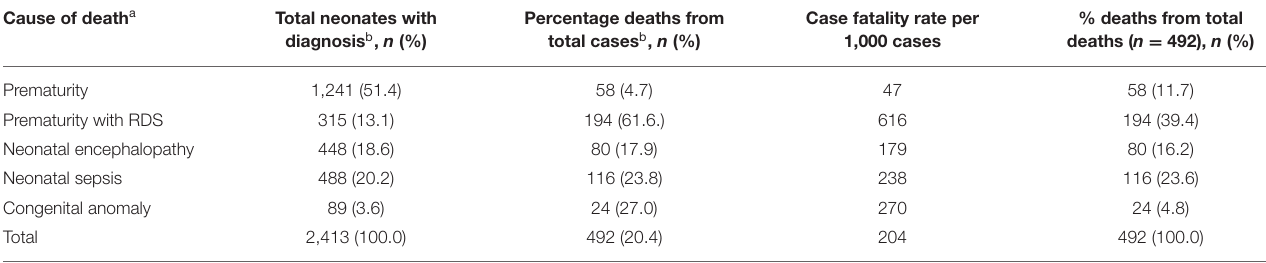
TABLE 2 | Cause of death and case fatality rates. Cause of death a Total neonates with